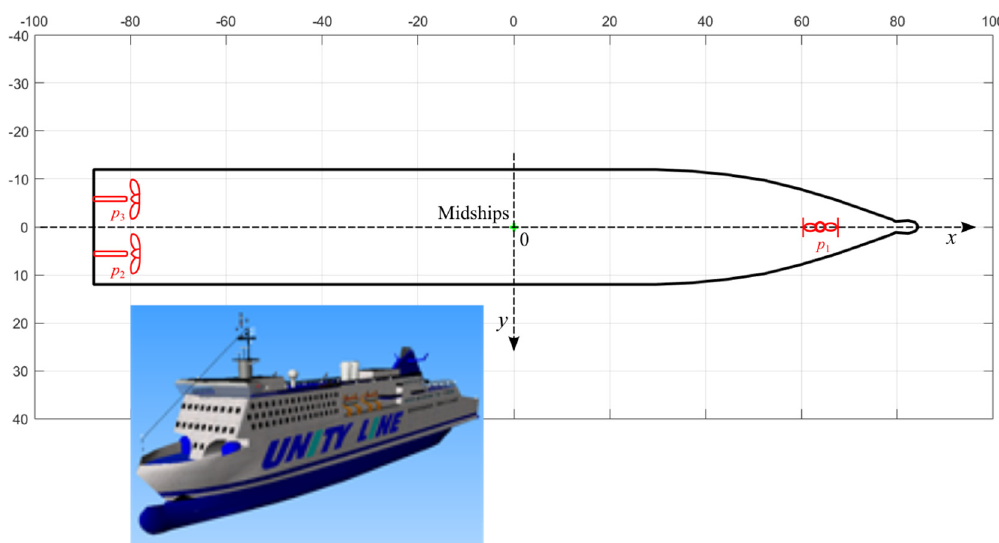
Figure 1. Ship dimensions and positions of thrusters in ship-body reference frame, and visualisation of the ferry. The implicit and explicit values of 45 ◦ thrust angle limits applied in (4a) and (4b) were set differently than the maximum passive stern rudder deflection of 35 ◦ for the ship. Since the allocation algorithm (presented in the next section) was basically designed for